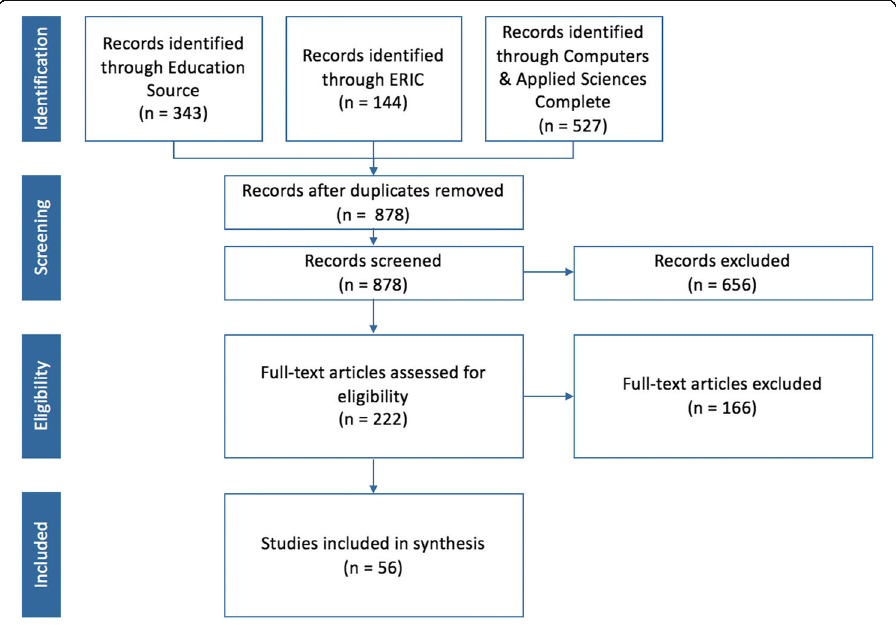
Fig. 2 PRISMA flow